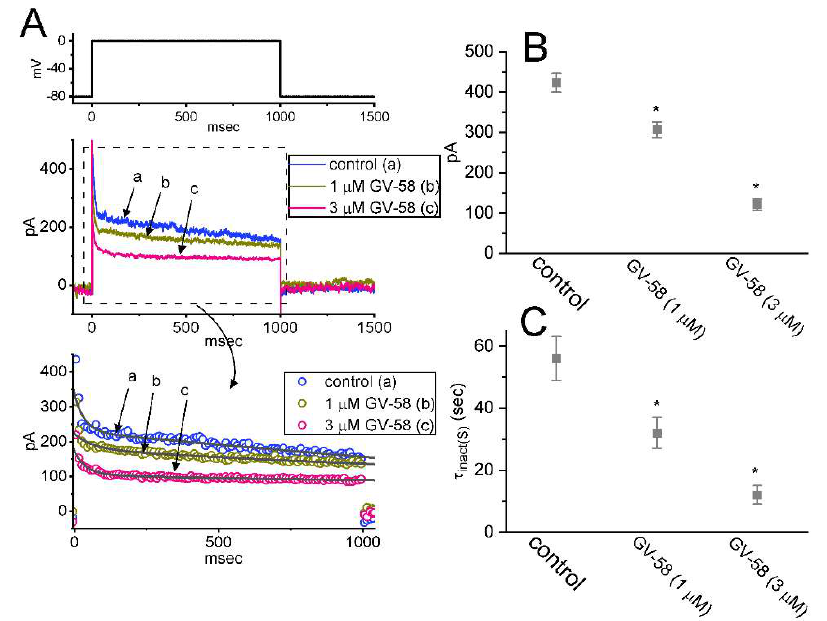
Figure 9. Inhibitory effect of GV − 58 on A − type K + current ( I K(A) ) in GH 3 cells. Cells were bathed in Ca 2+ − free Tyrode’s solution containing 1 μM TTX, and we filled up the pipette with K + − enriched solution. ( A ) Represent current traces obtained in the control period (“a”, i.e., absence of GV − 58) and during cell exposure to 1 μM GV − 58 (b) or 3 μM GV-58 (c). The uppermost part shows the voltage-clamp protocol applied. The lower part in ( A ) shows an expanded record from the dashed box, while the data points (circle symbols) were reduced by 50 for better illustration. The smooth line in the lower part represents best fit to two − exponential function (i.e., fast and slow components in current inactivation). Summary graphs appearing in ( B , C ) demonstrate inhibitory effects of GV − 58 (1 or 3 μM) on peak amplitude and slow component in inactivation time constant (τ inact(S) ) of I K(A) , respectively (mean ± SEM; n = 8 for each bar). * Significantly different from controls ( p < 0.05). Current amplitude was taken at the start of each depolarizing command voltage from −80 to 0 mV with a duration of 1 s. Of notice, cell exposure to GV − 58 is capable of decreasing both peak I K(A) and the τ inact(S) value of the current in these cells.